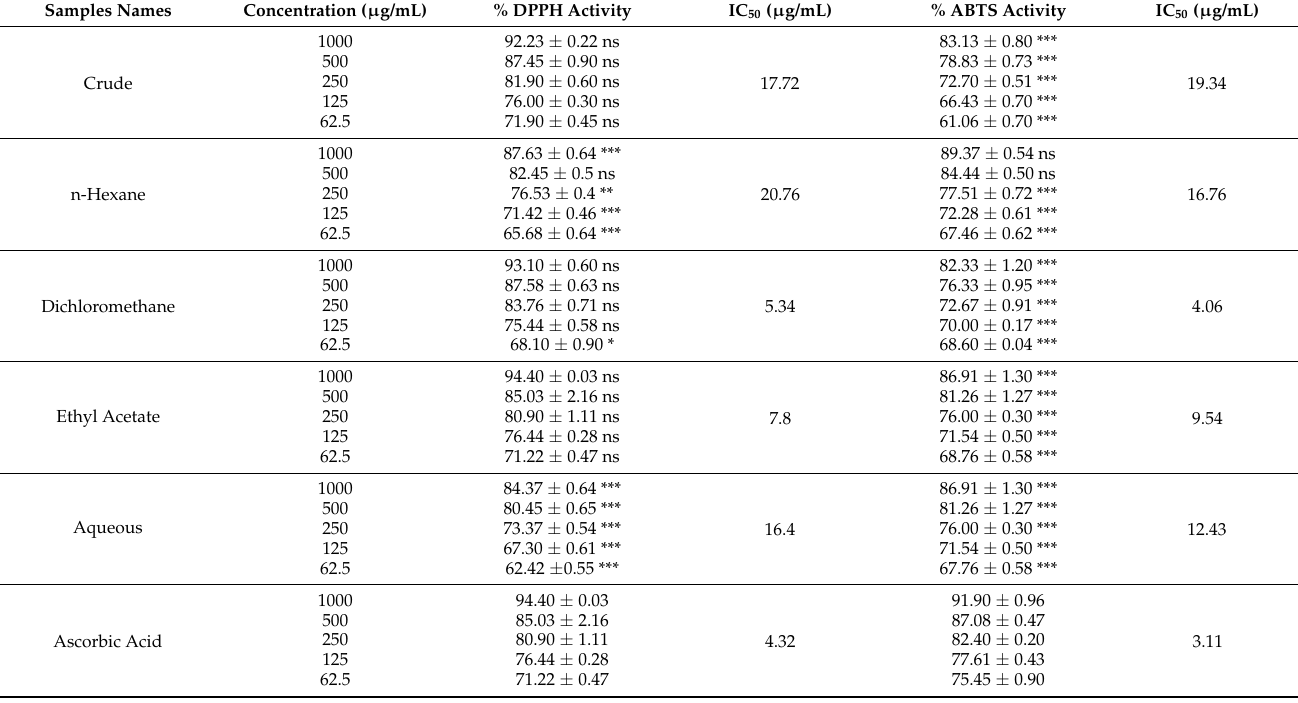
Table 2. DPPH and ABTS inhibitory assay of the Crude extract and different fraction of C.macrophylla